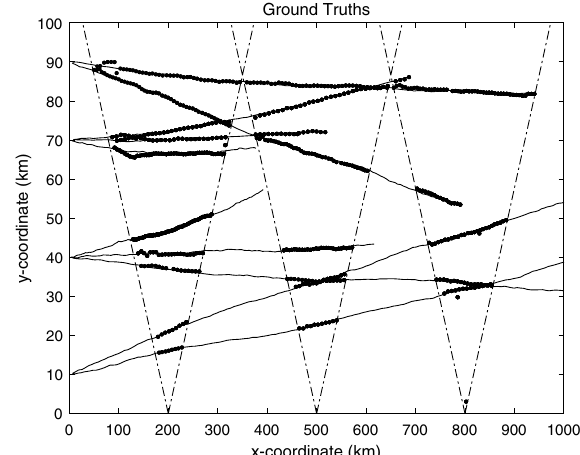
Fig. 8 Ground truths vs. estimated tracks(10